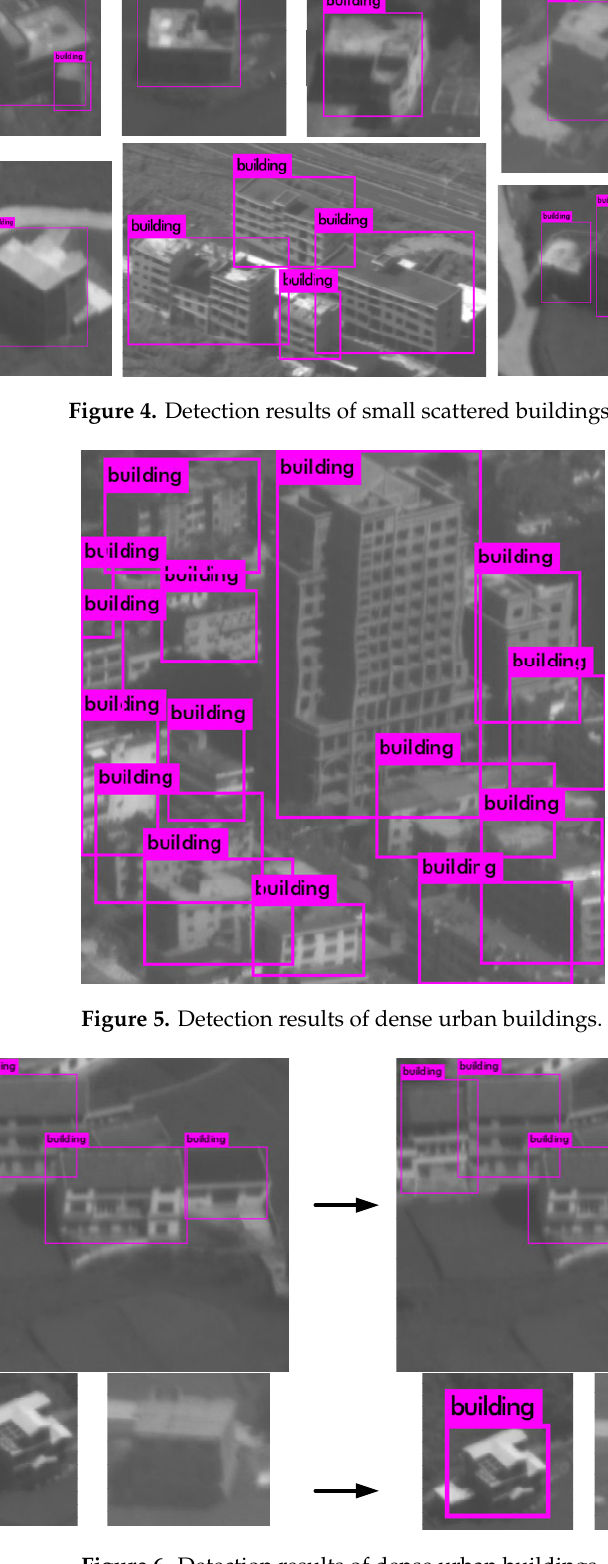
Figure 6. Detection results of dense urban buildings.